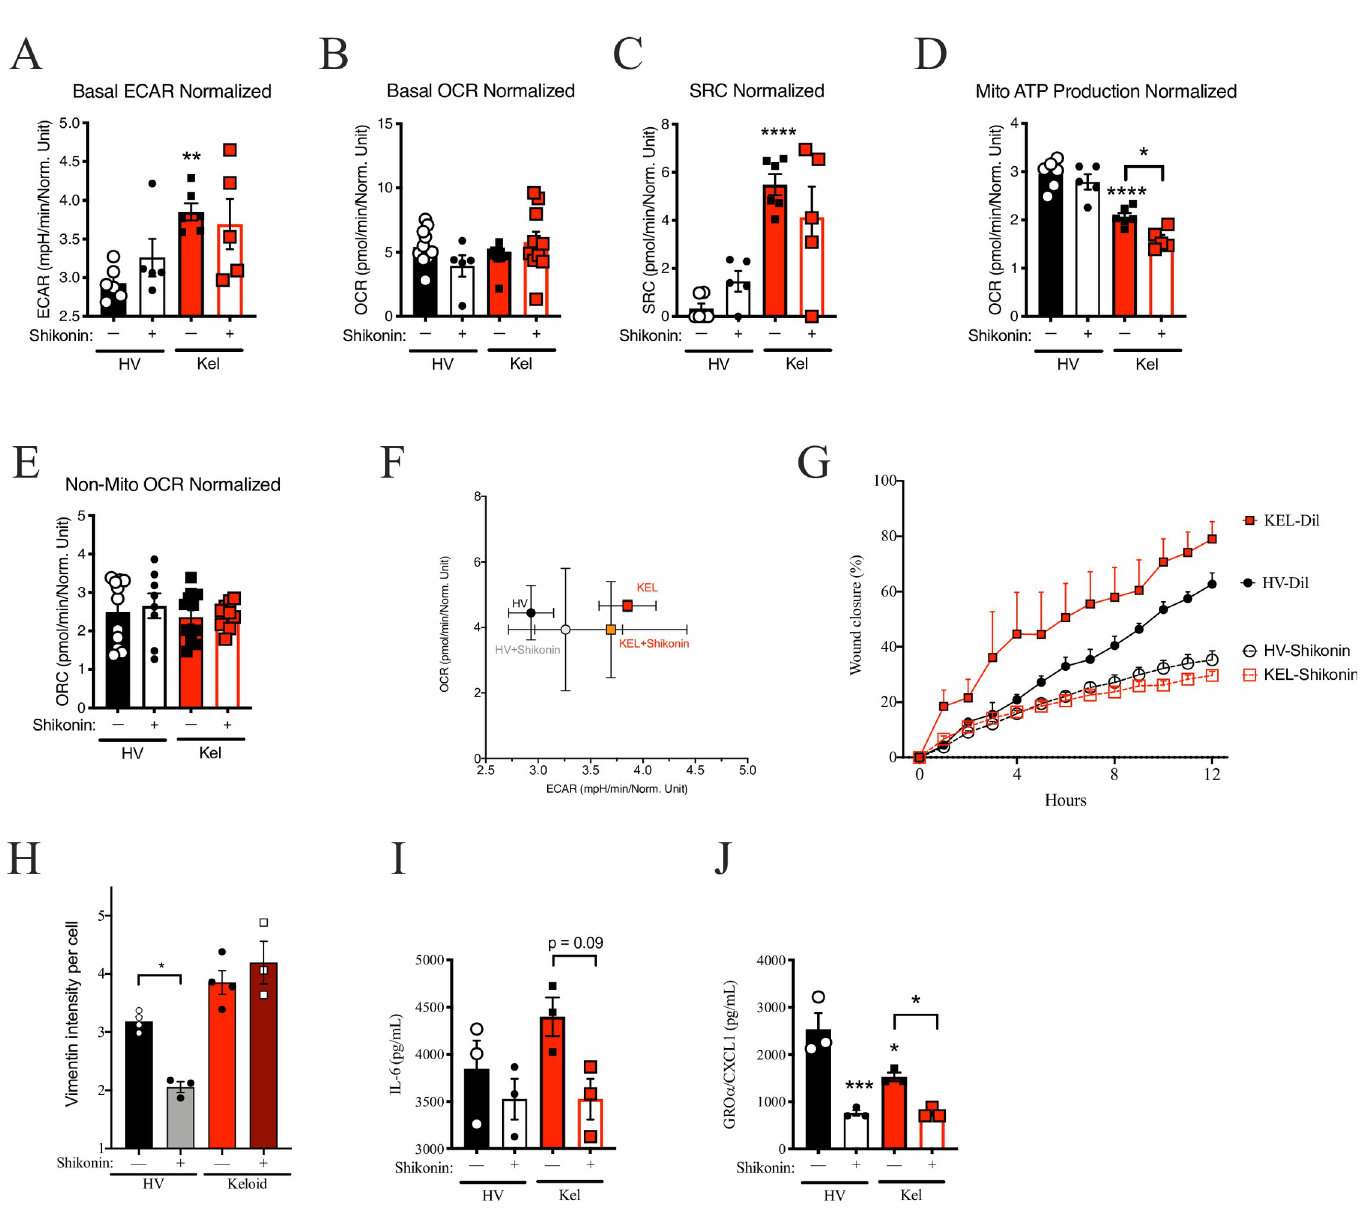
Fig 6. Shikonin impacts scratch outcomes without influencing metabolic function. (A-F) Seahorse assay results for keloid (KEL-) or health volunteer (HV-) fibroblasts (FB) for extracellular acidification rate (ECAR; A), basal oxygen consumption rate (OCR; B), spare respiratory capacity (SRC; C), mitochondrial (mito) ATP production (D), non-mitochondrial ATP production (E), and ratio of basal ECAR to OCR (F) are shown. (G) Wound closure as 12 hours for HV and KEL-FB after treatment with shikonin (10 μ M). (H) Mean fluorescence intensity (MFI) per cell for vimentin for HV-FB and KEL-FB treated with shikonin (10 μ M). (I-J) Supernatant accumulation of interleukin (IL-) 6 (I) and CXCL1 (J). Results are representative of three independent experiments and displayed as mean + SEM (A-E, G-J) or SD (F) for triplicate wells. � = p < 0.05; �� = p < 0.01; ��� = p < 0.001; ���� = p < 0.0001 as determined by ANOVA with Sidak adjustment compared with HV in under similar conditions unless